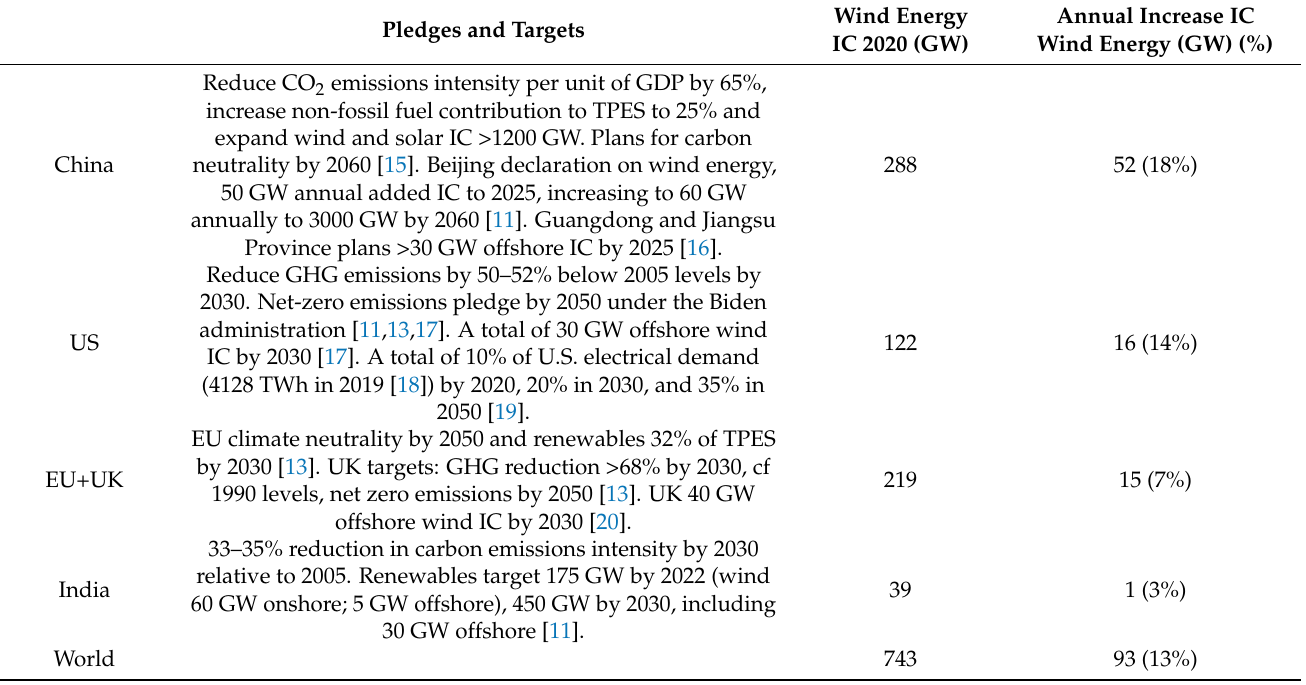
Table 2. Climate-relevant pledges and targets. Additionally shown are installed capacity (IC) of wind energy in 2020 and historical annual rates of increase in IC [11]. Pledges and